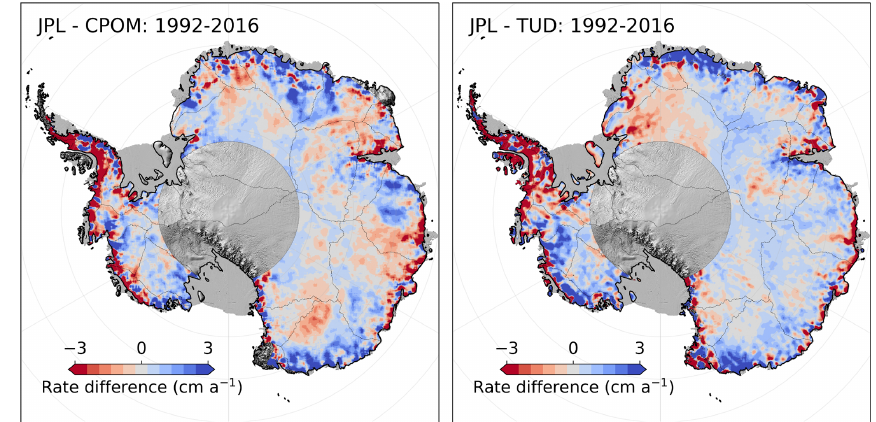
Figure 8. Comparison of overlapping long-term rates from the Technical University of Dresden (TUD) and Center for Polar Observation and Modelling (CPOM) altimetry product with rates from this study (JPL).